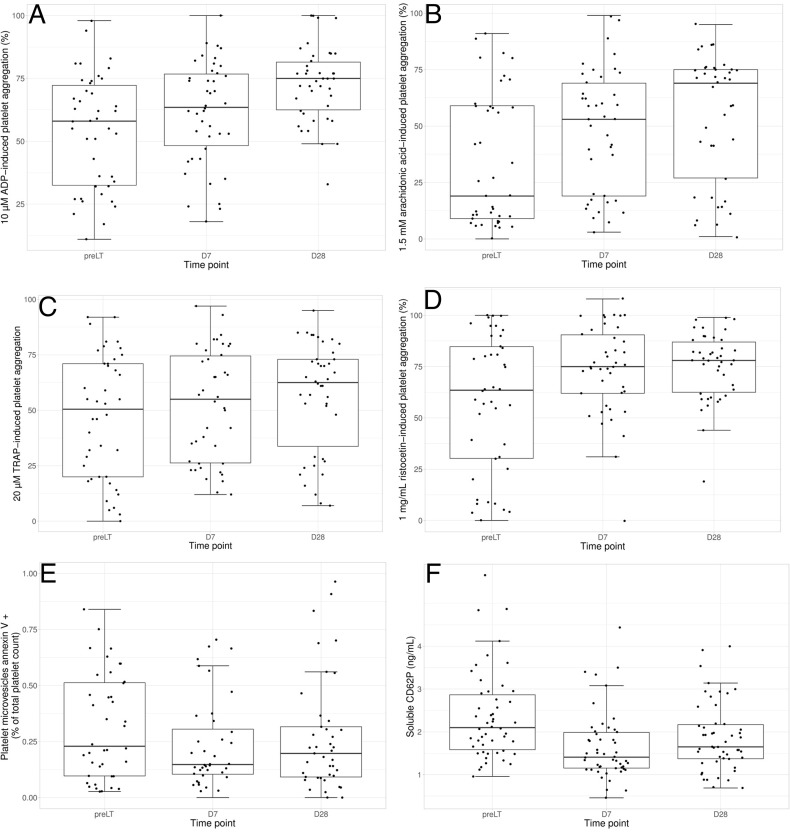
Boxplots at different time points for (A) 10 μM ADP-induced platelet aggregation, (B) 1.5 mM arachidonic acid-induced platelet aggregation, (C) 20 μM TRAP-induced platelet aggregation, (D) 1 mg/mL ristocetin-induced platelet agglutination, (E) platelet microvesicles as a % of total platelet count, (F) soluble CD62P. Horizontal lines show median values and the 25–75 percentiles. Pre LT: pre liver transplantation.